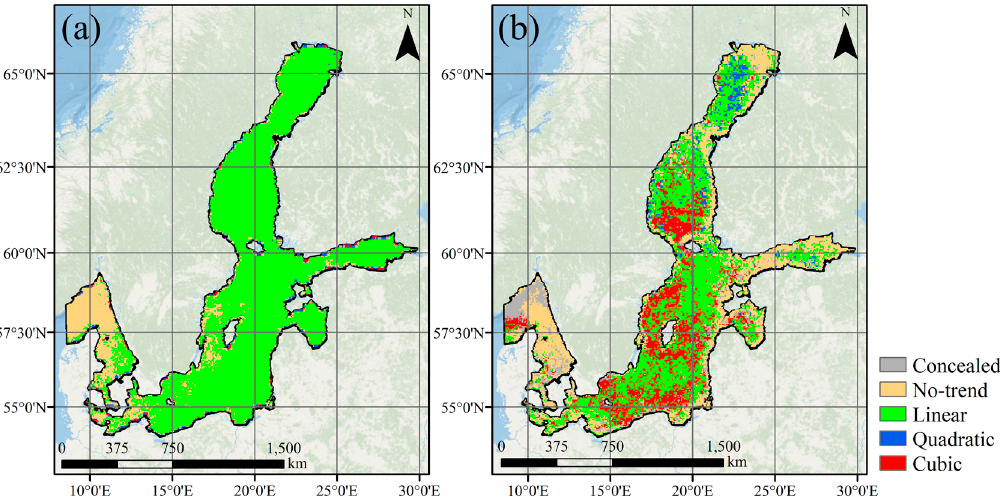
Figure 3. Sea surface temperature (SST) trend maps of the Baltic Sea over the last four decades derived using ( a ) annual maximum and ( b ) annual minimum SST values of AVHRR Pathfinder data acquired at night.